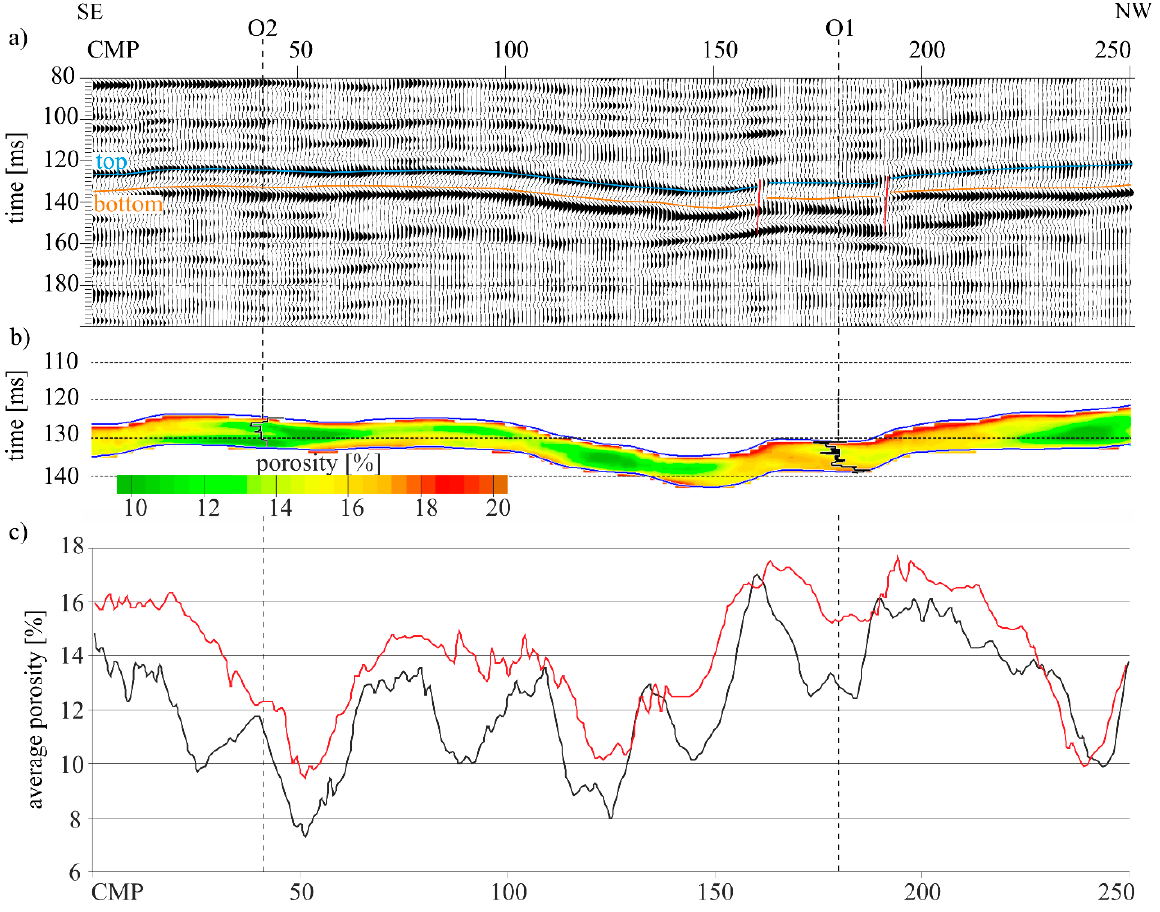
Figure 11. ( a ) Seismic cross section (see Figure 9 for description); ( b ) spatial distribution of porosity within the deposit derived from seismic inversion, with porosity logs displayed; ( c ) diagrams showing calculated porosity: red line—average porosity from seismic inversion, black line—porosity from amplitude of reflection from the top of deposit.